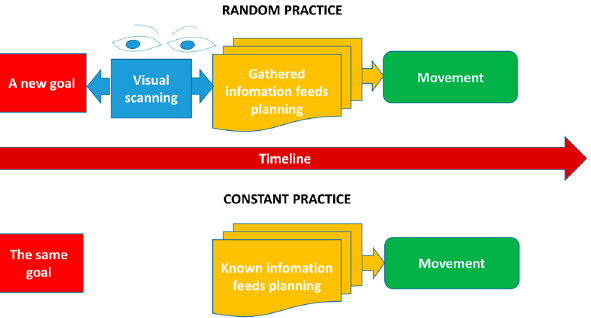
Figure 7. Process of visual scanning to gather information before movement planning. Random practice demand changes trial-by-trial in the absolute dimension requiring visual scanning from the learner to gather information about the new goal. In constant practice, the goal is the same trial-by-trial, diminishing the relevance of visual scanning and gathering information over the course of